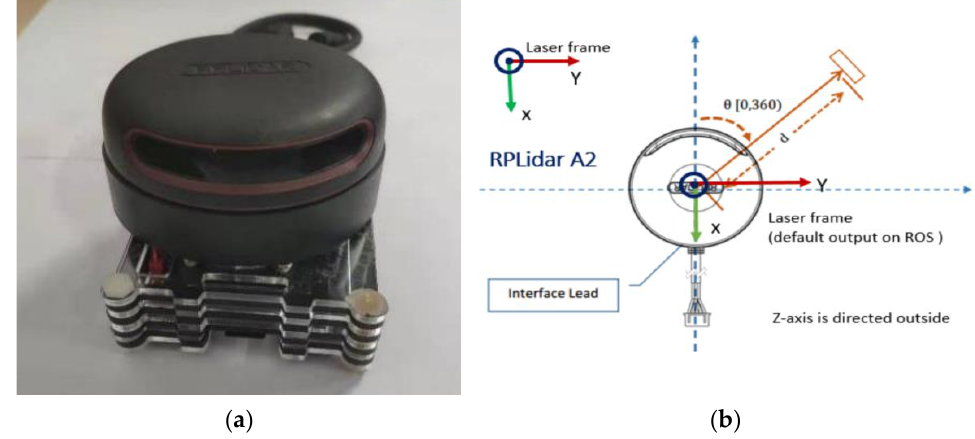
Figure 15. ( a ) Silan RPLIDAR A2 LiDAR. ( b ) Working principle of RPLiDAR A2.